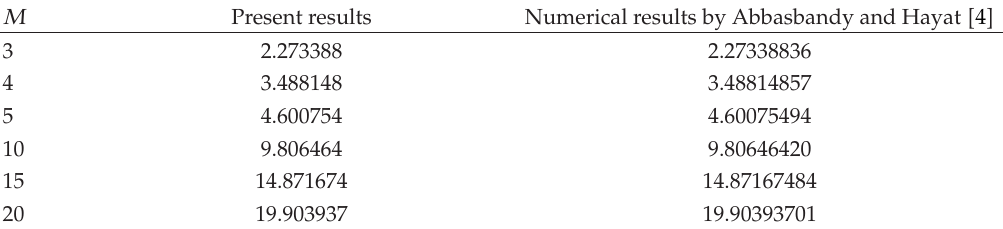
Table 2: (cid:2) 10 , 10 (cid:3) homotopy-Pade approximation at m (cid:8) − 3 / 5 , λ (cid:8) 0 , γ (cid:8)